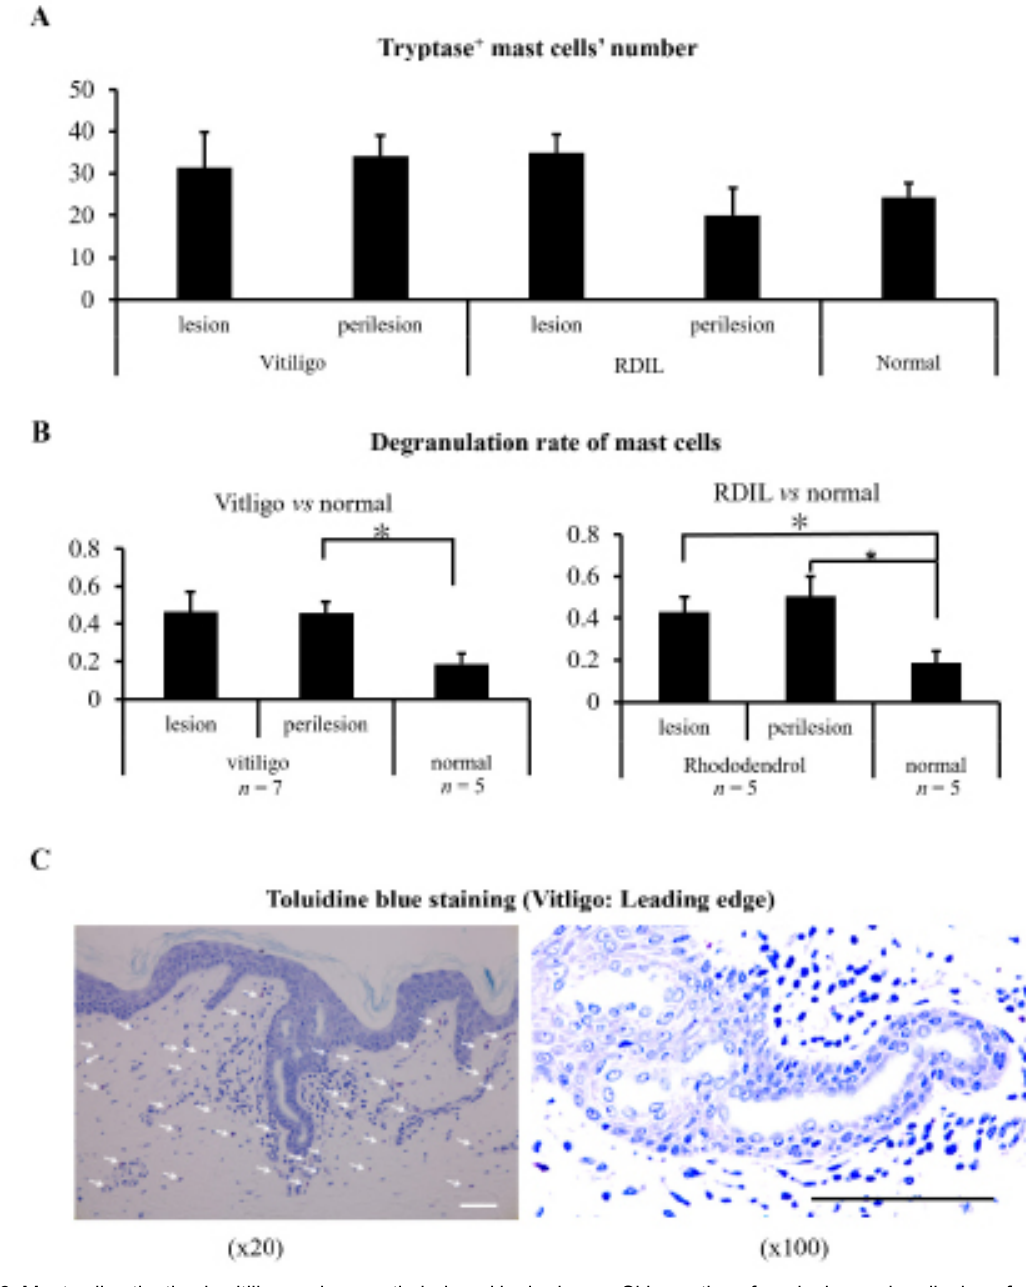
Figure 3. Mast cell activation in vitiligo and cosmetic-induced leukoderma. Skin sections from lesion and perilesion of vitiligo, RDIL and healthy control (normal) were stained with toluidine blue, and then the mast cell number were counted (A), the degranulation rate was calculated (B). The presentative image of toludine blue staining was shown (C). Scale bar: 100